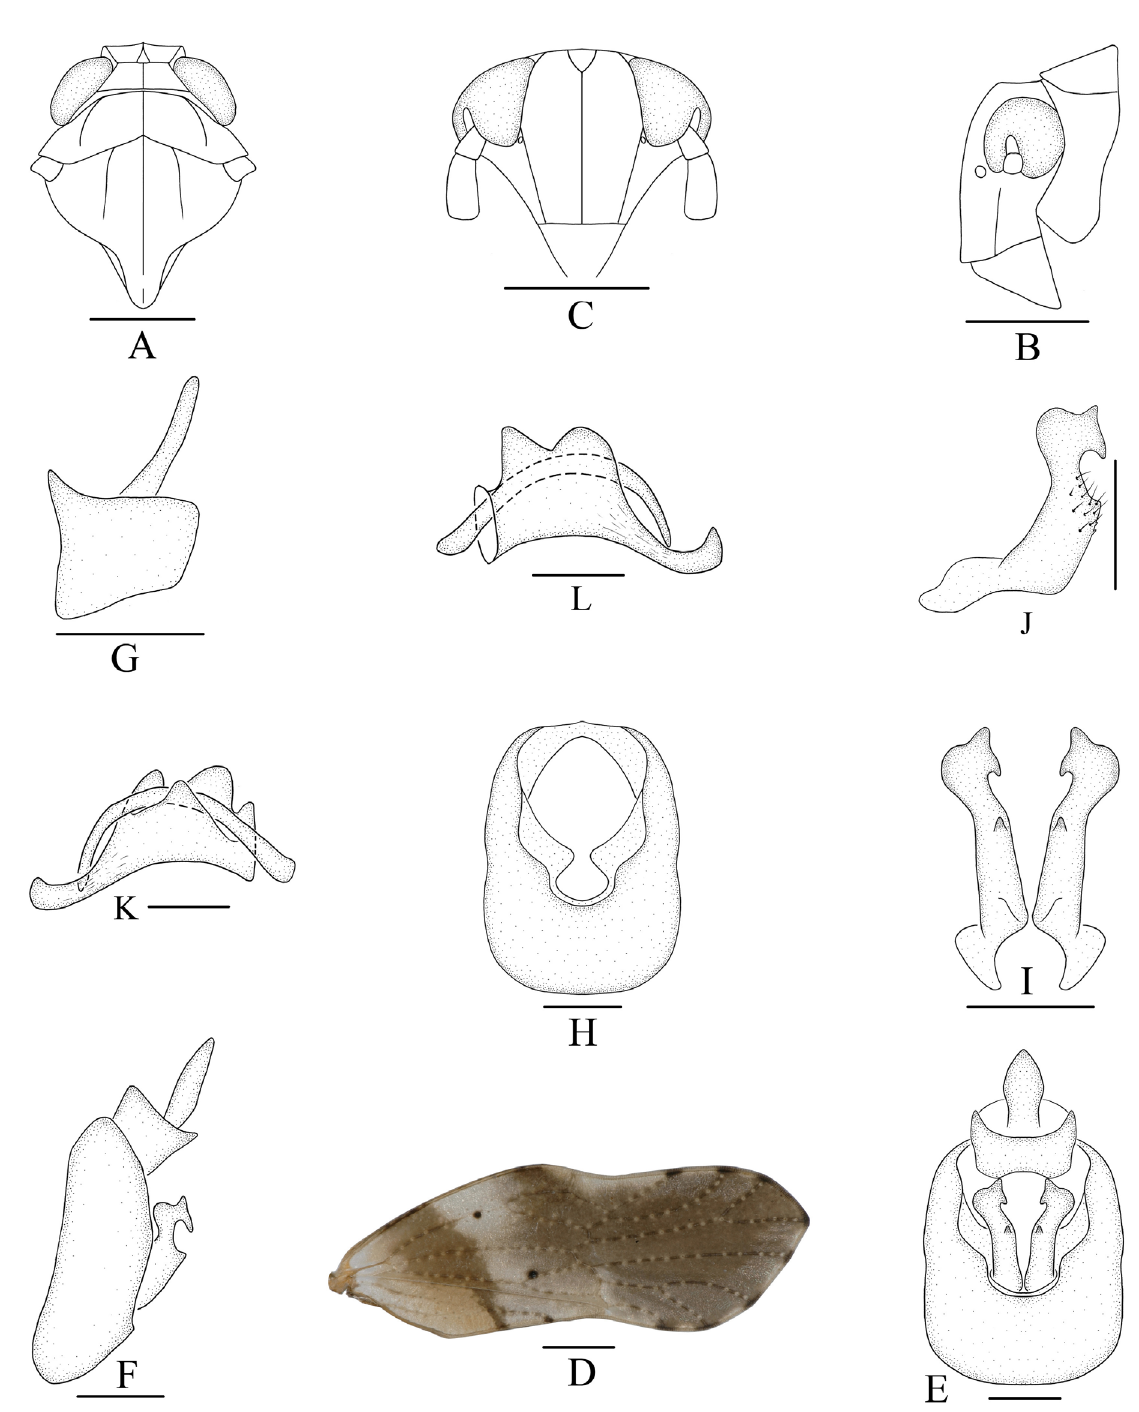
Fig. 4. Arcofaciella obflexa Guo & Liang, 2005, ♂ (GUGC-FDTA-20190601). A . Head and thorax, dorsal view. B . Same, lateral view. C . Face. D . Forewing. E . Male genitalia, posterior view. F . Same, lateral view. G . Anal segment, lateral view. H . Pygofer, posterior view. I . Genital style, posterior view. J . Same, lateral view. K . Aedeagus, right lateral view. L . Same, left lateral view. Scale bars: A–D = 0.5 mm; E–J = 0.2 mm; K–L = 0.1